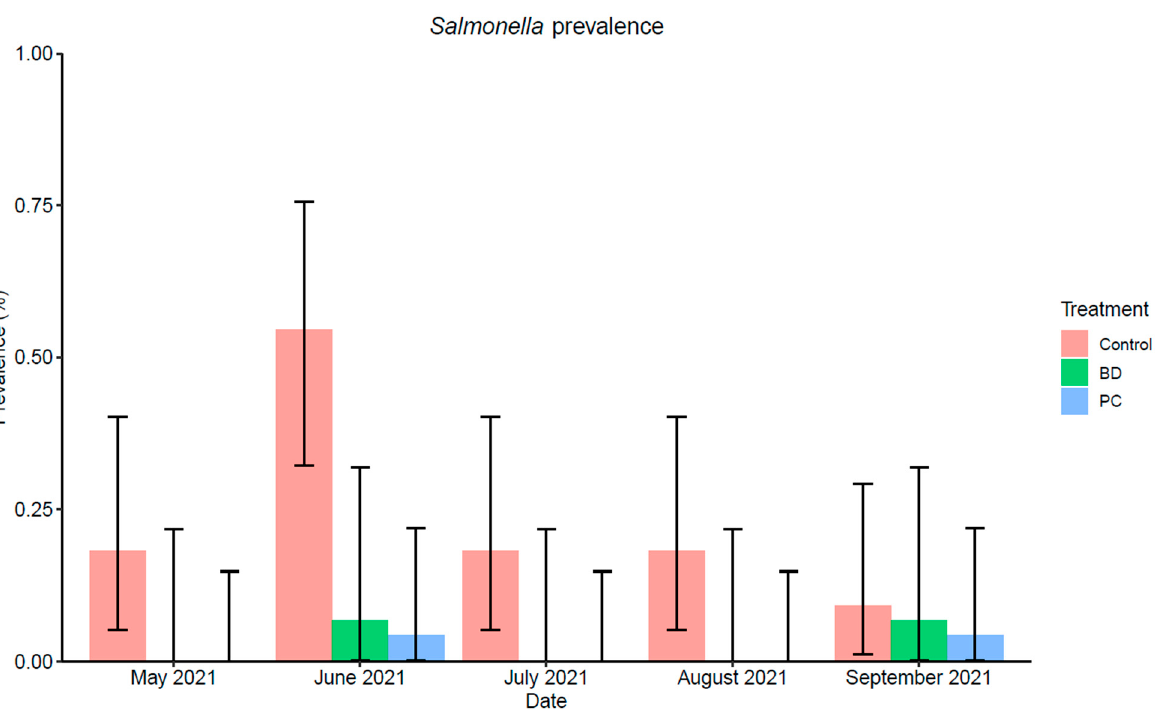
Figure 2. Salmonella prevalence (%) in fecal samples collected from the pen floors over the course of a 5-month sampling period at three different feed yards ( n = 3 pens/feed yard). Control (May: 4/22, June: 12/22, July: 4/22, August: 4/22, September: 2/22); BD (May: 0/15, June: 1/15, July: 0/15, August: 0/15, September: 1/15); PC (May: 0/23, June: 1/23, July: 0/23, August: 0/23, September: 1/23). Error bars represent 95% confidence intervals (CI).